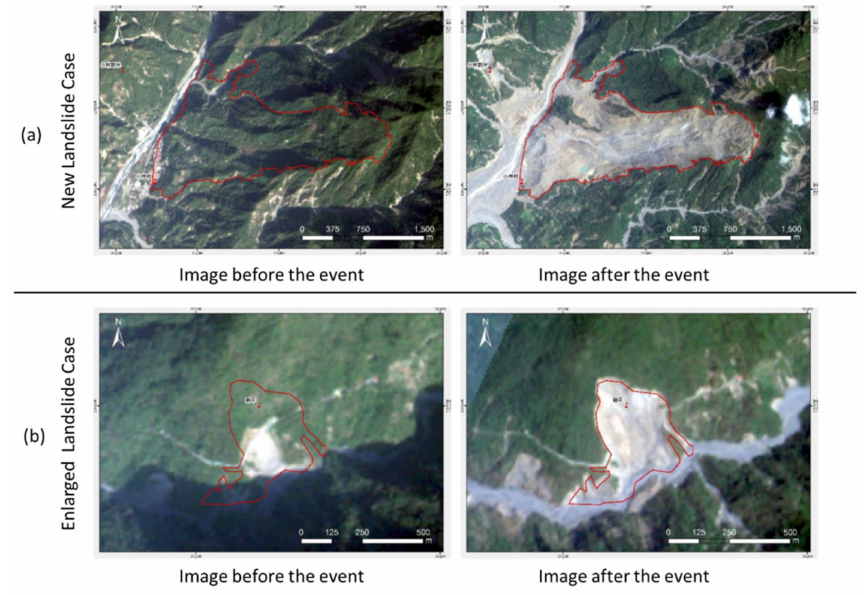
Figure 7. Classification for new landslide and enlarged landslide. ( a ) Before the event, there is no obvious landslide to be found; ( b ) before the event, some landslides were found at the location of the